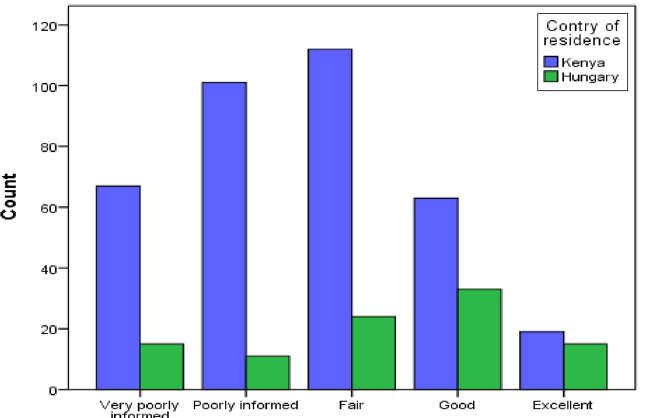
Figure 2. The figure demonstrates the significant difference between the two sampled populations regarding knowledge of vaccine efficacy, (1–5 Likert scale, the x-axis represents responses from respondents, the y-axis represents the count in frequency).